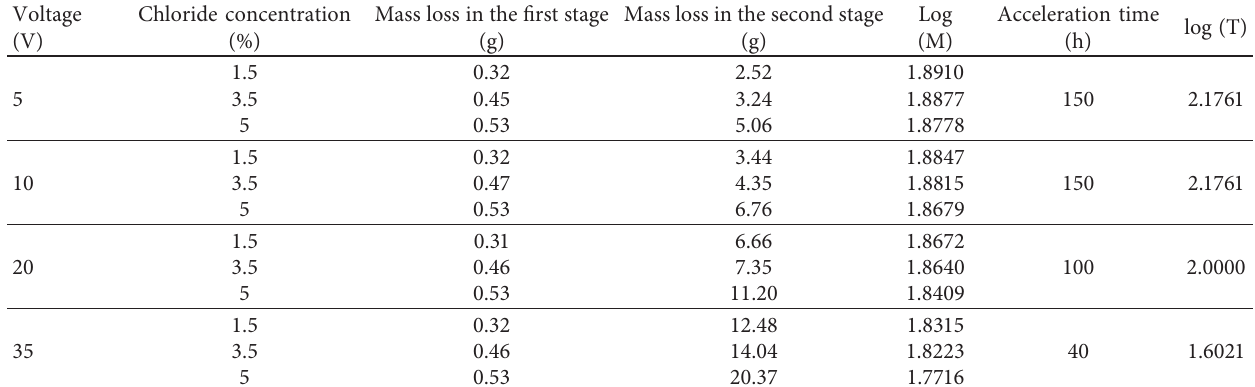
Figure 6: Crack characteristics and damage degrees of samples. (a) Cracks. (b) Longitudinal. (c) Transverse. Table 4: Mass loss and the logarithm of residual mass of